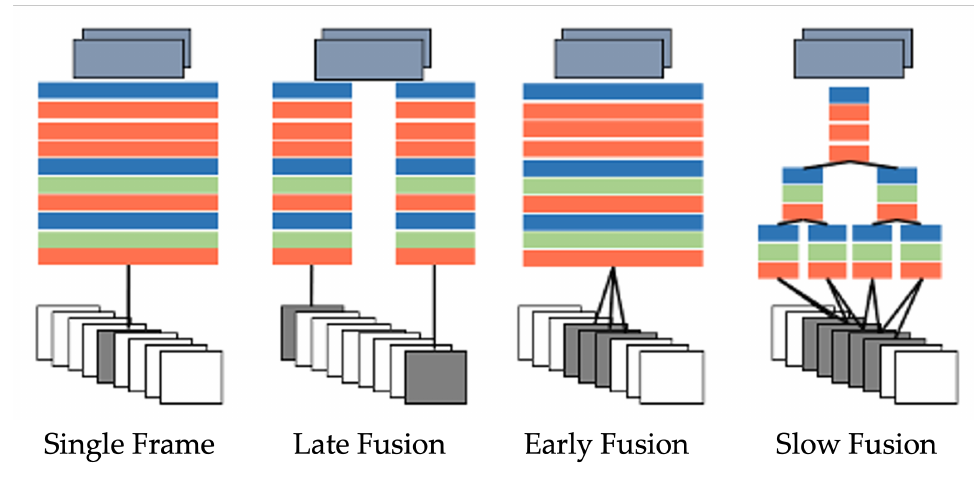
Figure 1. Temporal data fusion method to